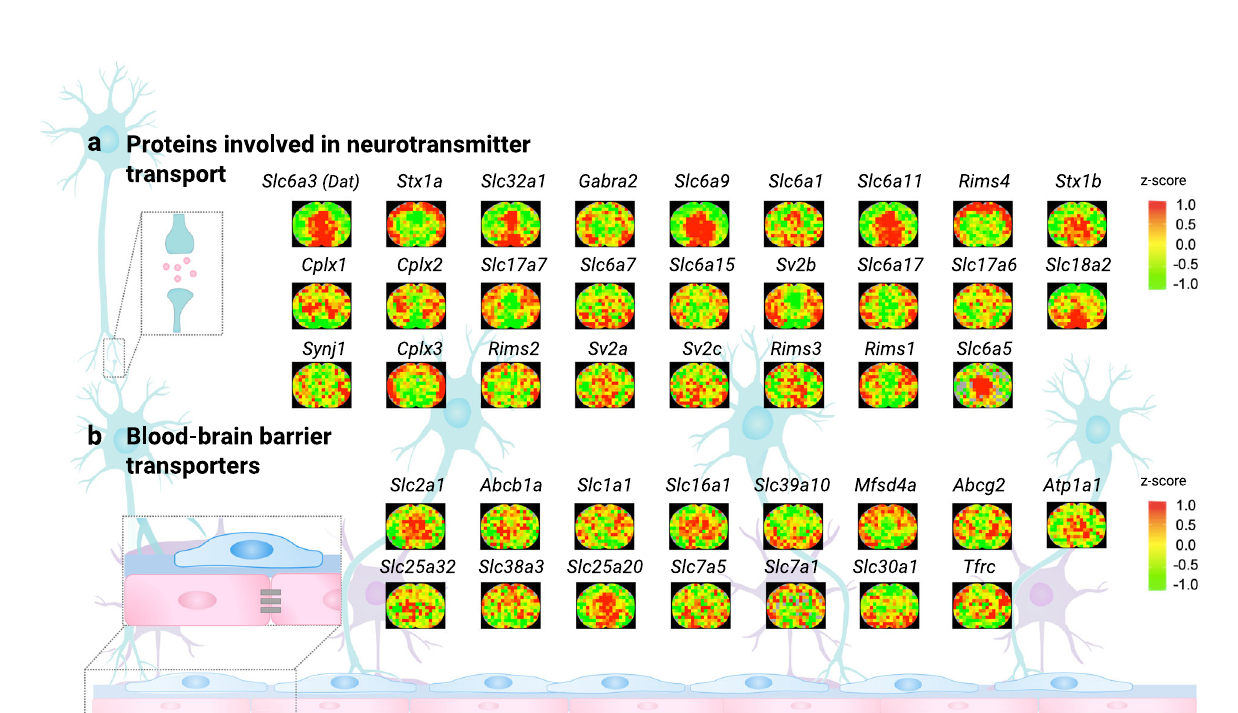
Fig. 7 | The maps of proteins involved in neurotransmitter transport and transporters expressed on the blood-brain barrier acquired by MASP. a The spatial distribution maps of proteins involved in the neurotransmitter transport